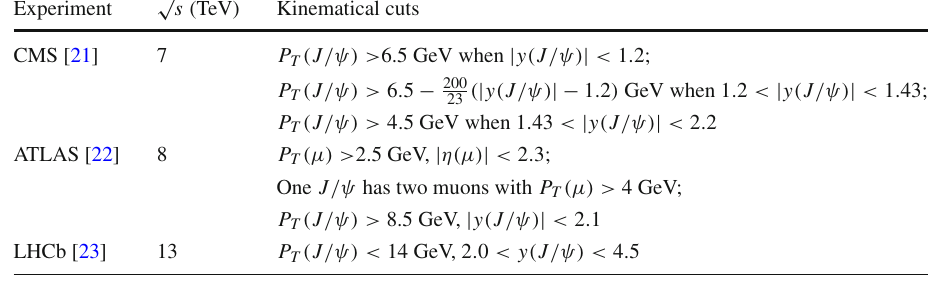
Table 2 Summary of